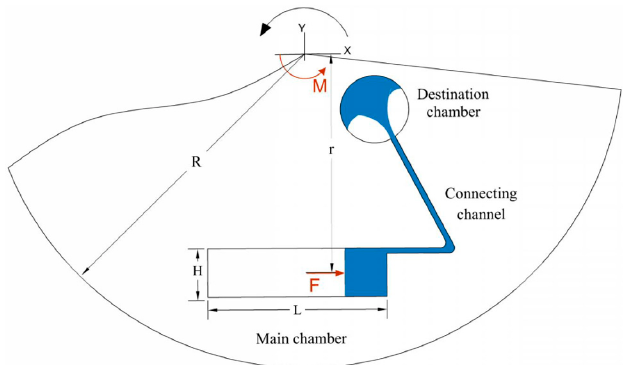
Figure 2. The schematic view of showing the effective parameters, the microchannel connecting the source and the destination chamber.